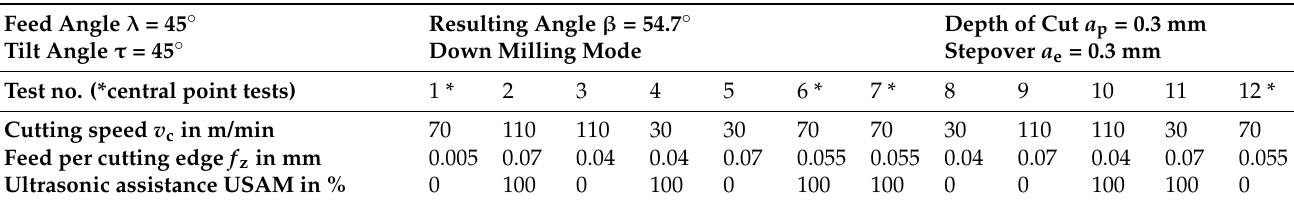
Table 2. Design of experiment with fixed parameters shown on top and parameters varying along the experiment